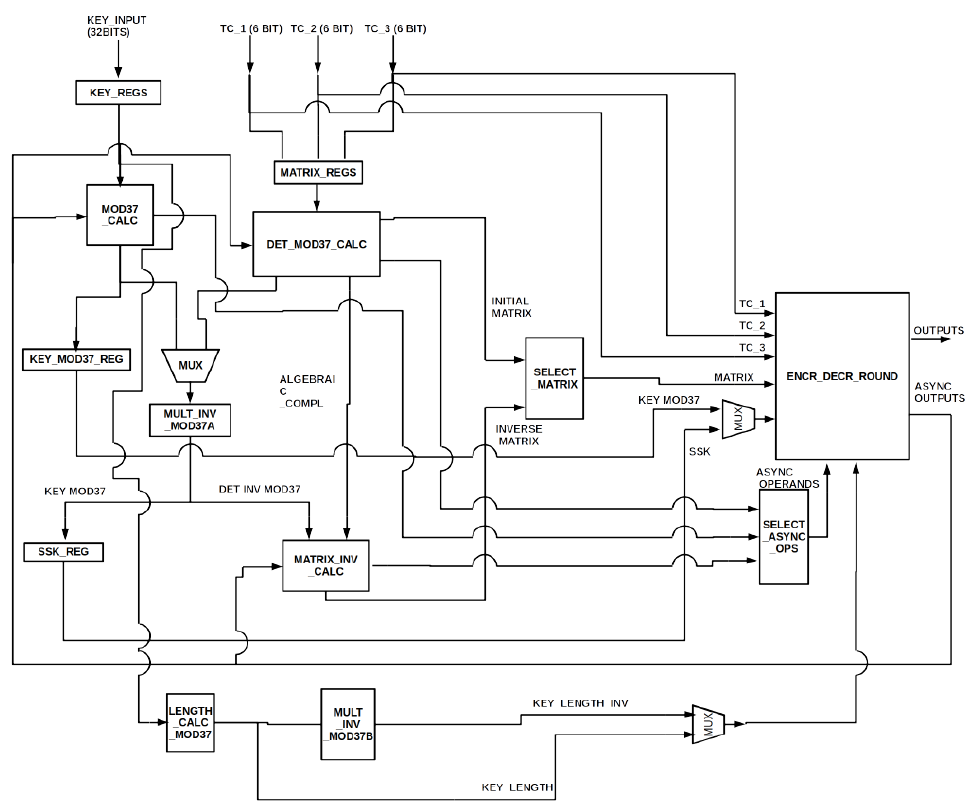
Figure 5. Proposed architecture of cryptographic primitive.